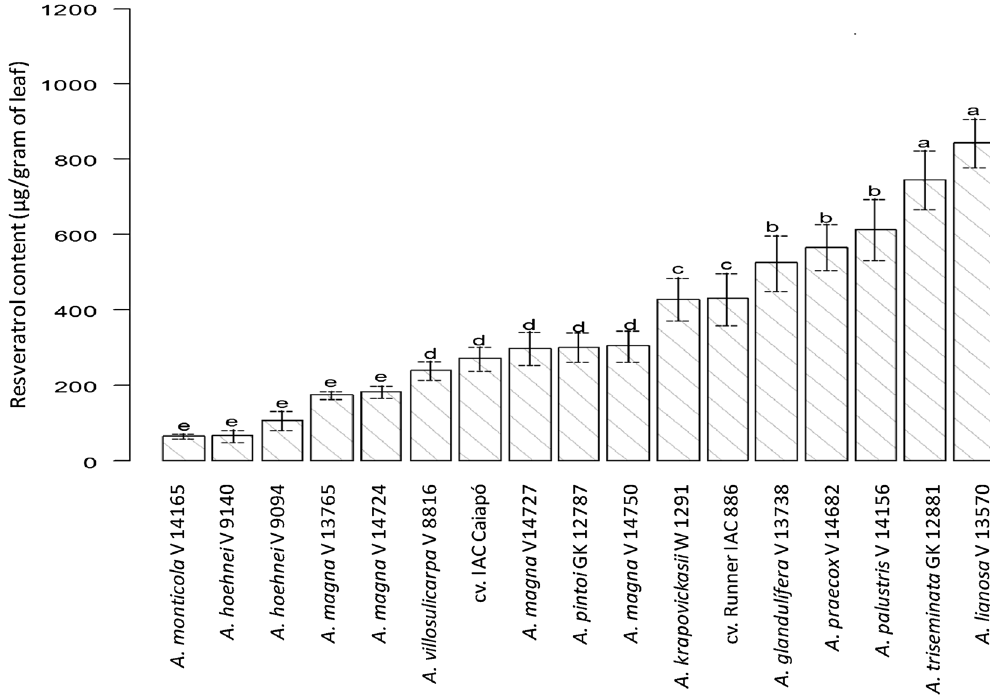
Figure 1. Resveratrol content in 17 accessions of 12 species of Arachis, after UV radiation exposure for 2h30min. Means followed by the same letter do not differ (α < 0.05) according to Scott-Knott